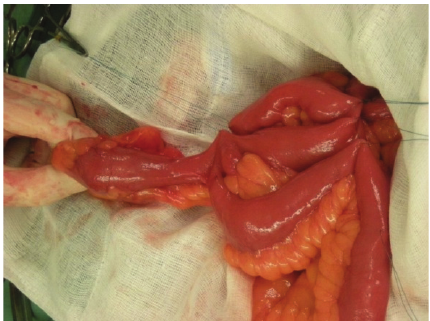
Figure 1: Meckel’s diverticulum.